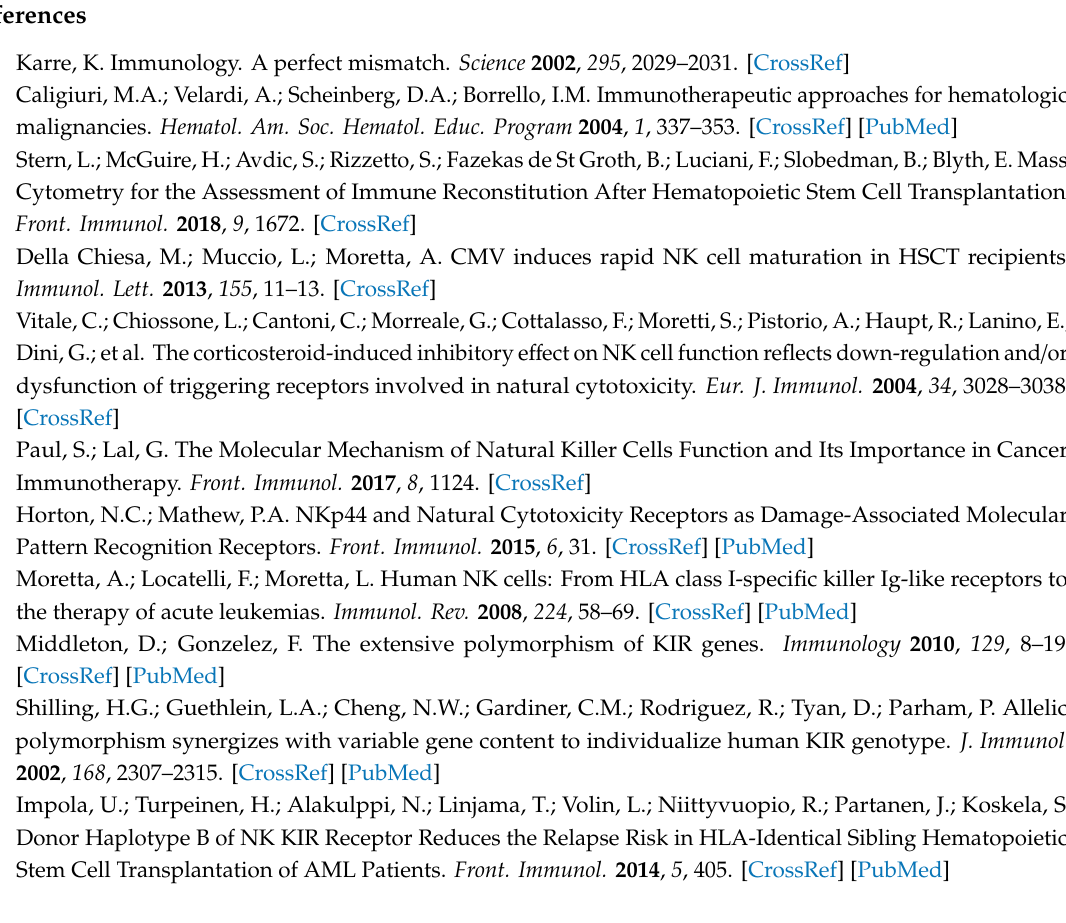
Figure S1: The KIR receptor evaluation gating strategy; Figure S2: Determination of the cytotoxic activity of NK cells.; Table S1: The role of KIR2DL1